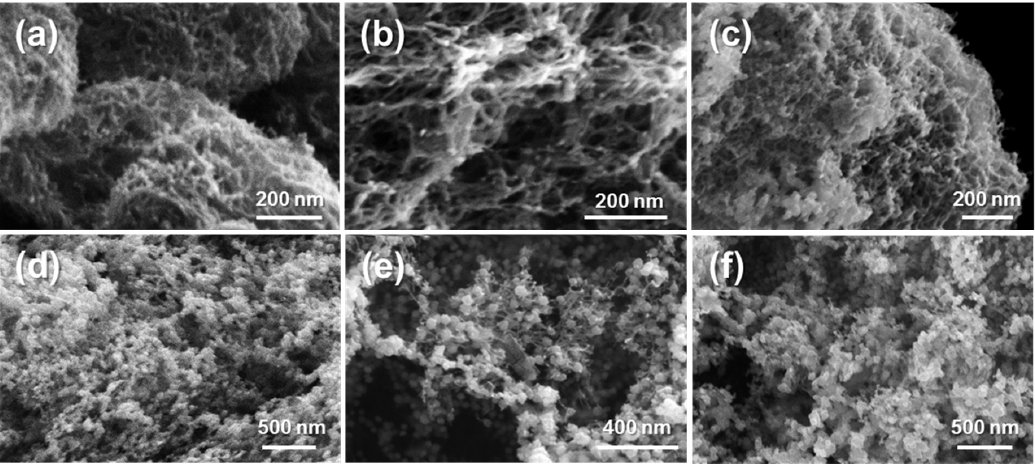
Figure 3. Scanning electron microscopy images of CNF-Pd composite aerogels prepared